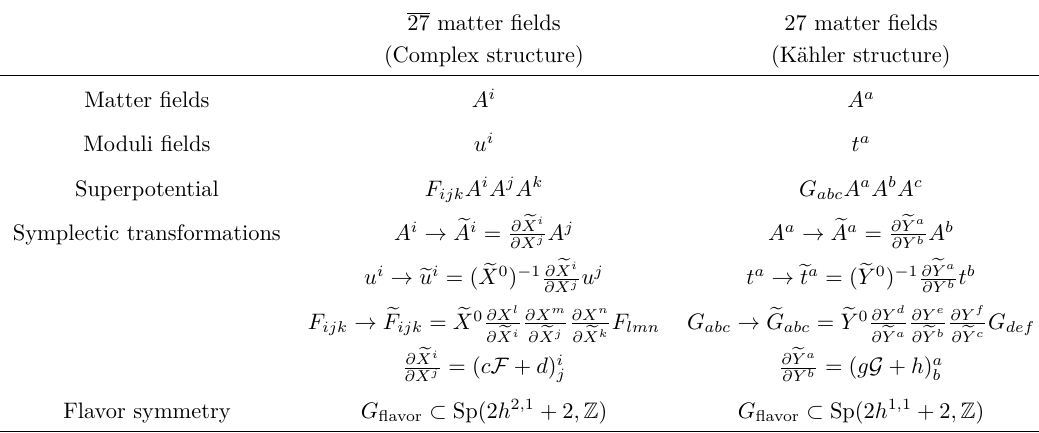
Table 2 . Symplectic modular flavor